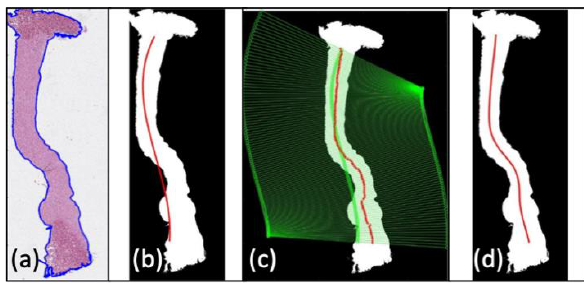
Figure 4. Automatic procedure for the identification of the cornea section boundaries and center-line; ( a ) section boundaries after thresholding and morphological filtering; ( b ) initialization of the center line with a polynomial (red); ( c ) analysis of straight lines (green) normal to the polynomial and update of the center points (red circles); ( d ) the final estimate of the center line. The stroma located on the right of the corneal section represents the anterior part of the cornea; the stroma located on the left side represents the inner (posterior) stroma.